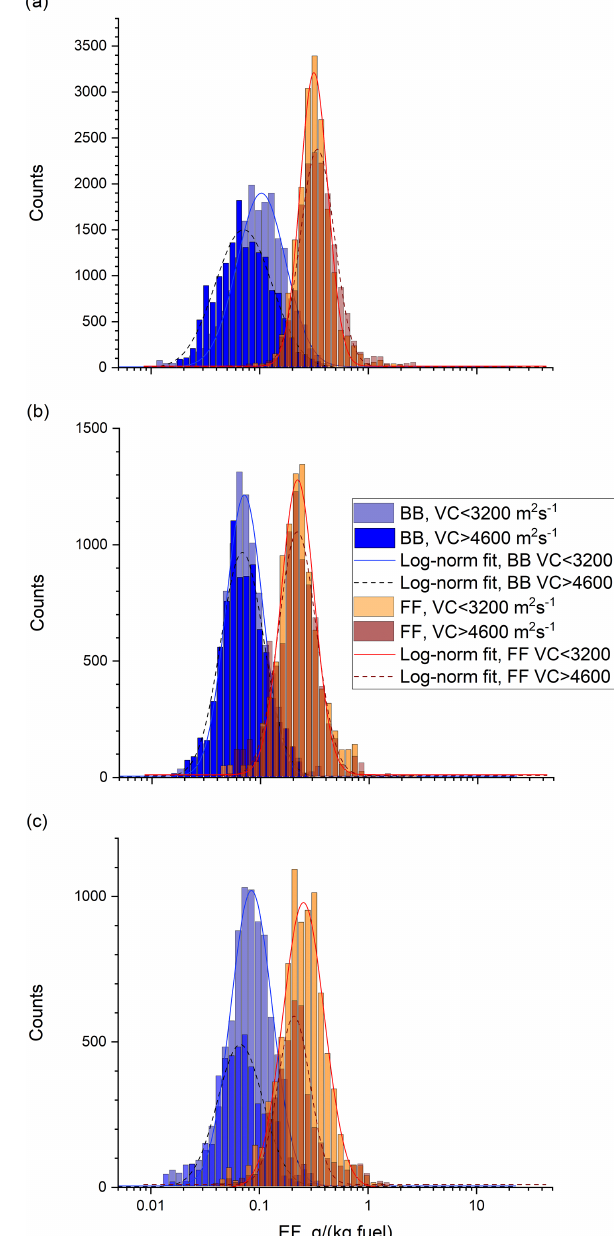
Figure 6. FF-related (brown bars) and BB-related (blue bars) emis- sion factors at the (a) BTC, (b) SKY, and (c) TRO locations, re- spectively. Low (VC < 3200m 2 s − 1 ) and high (VC > 4600m 2 s − 1 ) ventilation cases were plotted separately. Lognormal distributions (solid and dashed lines) were fitted to the results: the parameters are summarized in Table